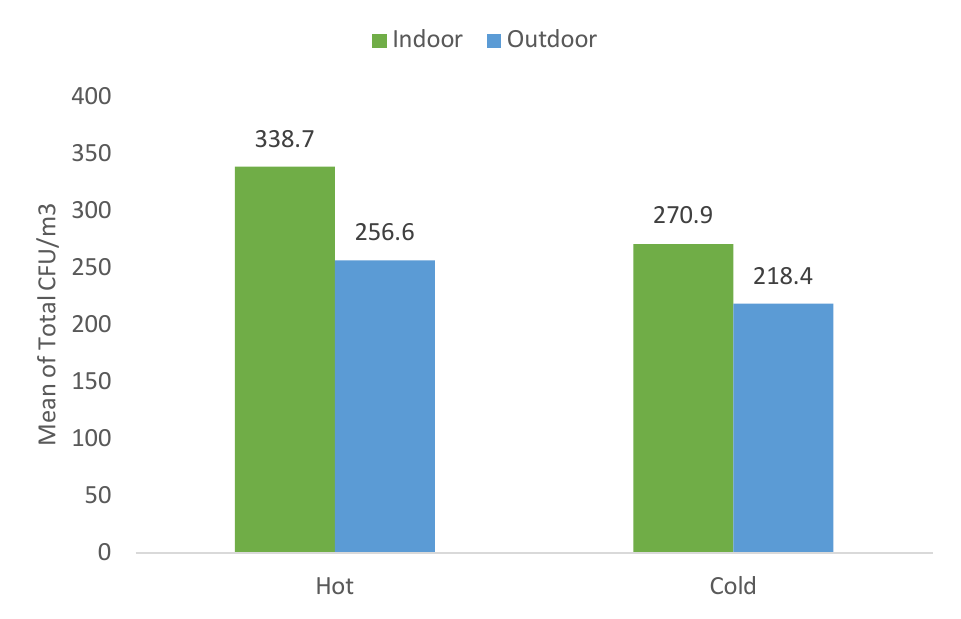
Figure 4. The total mean of indoor and outdoor airborne concentration (CFU/m 3 ) during the hot and cold seasons at all health